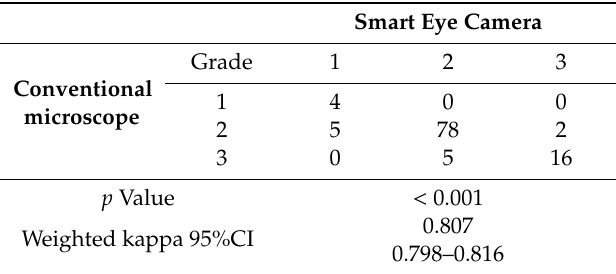
Table 3. Reproducibility of the cataract grading evaluated by the two devices .